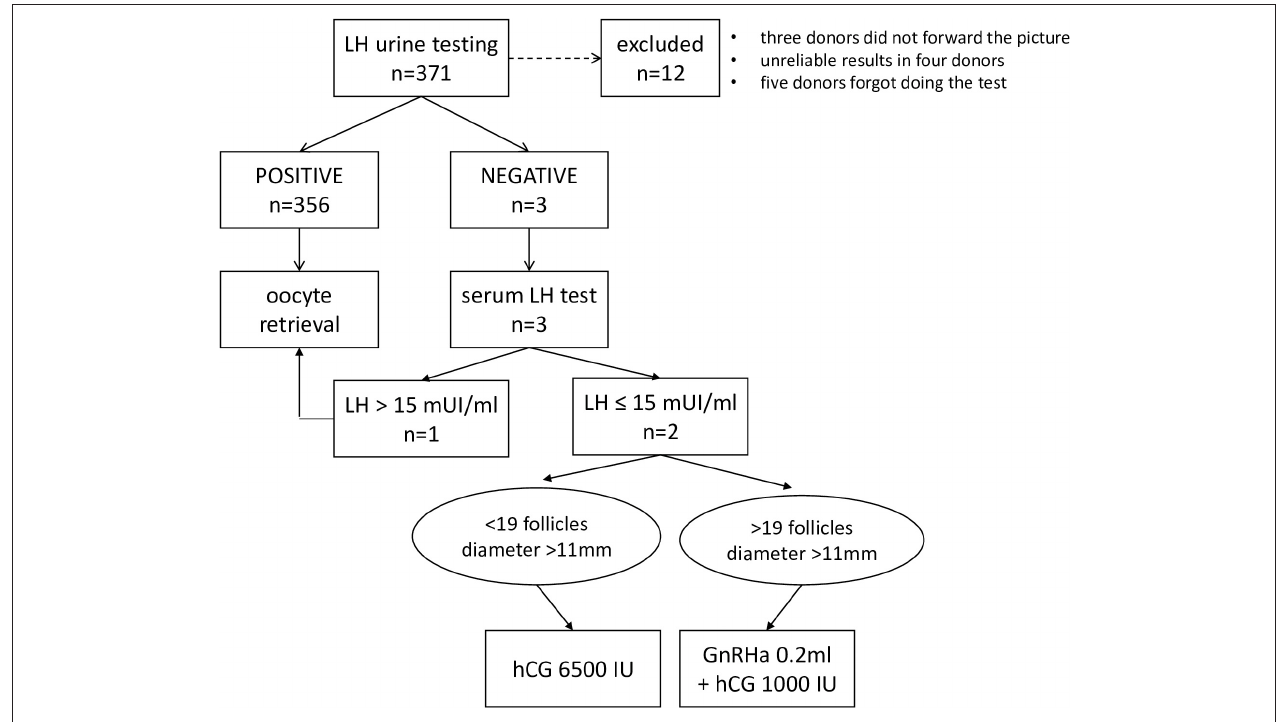
FIGURE 1 | Flow chart according to LH urine testing results.